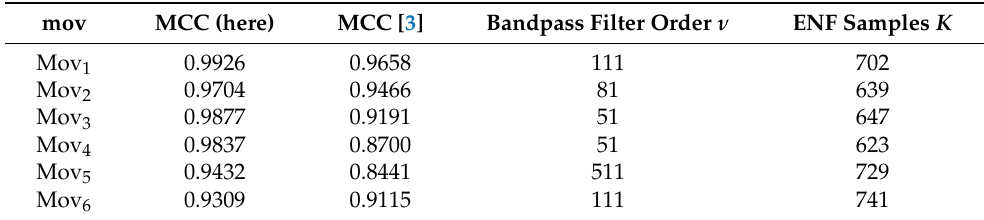
Table 3. Maximum correlation coefficient of the proposed approach employing either STFT or ESPRIT and the MUSIC [3] for all recordings. The filter order employed is also quoted. mov MCC (here) MCC [3] Bandpass Filter Order ν ENF Samples K Mov 1 0.9926 0.9658 111 702 Mov 2 0.9704 0.9466 Mov 3 0.9877 Mov 4